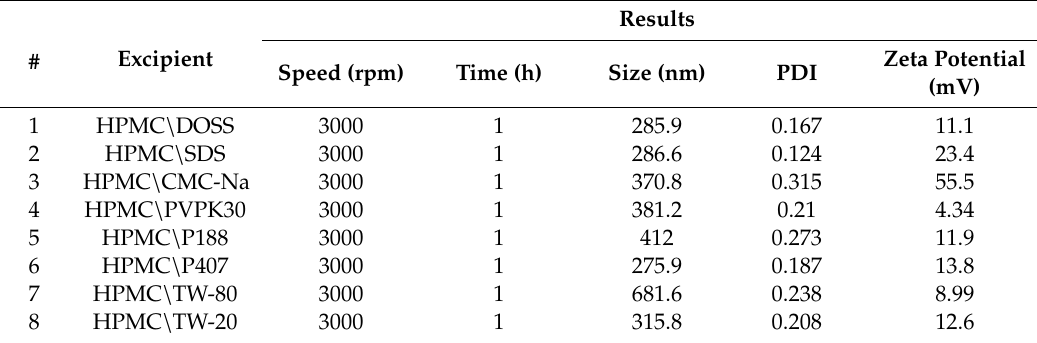
Table 4. Results of the particle size and zeta potential.